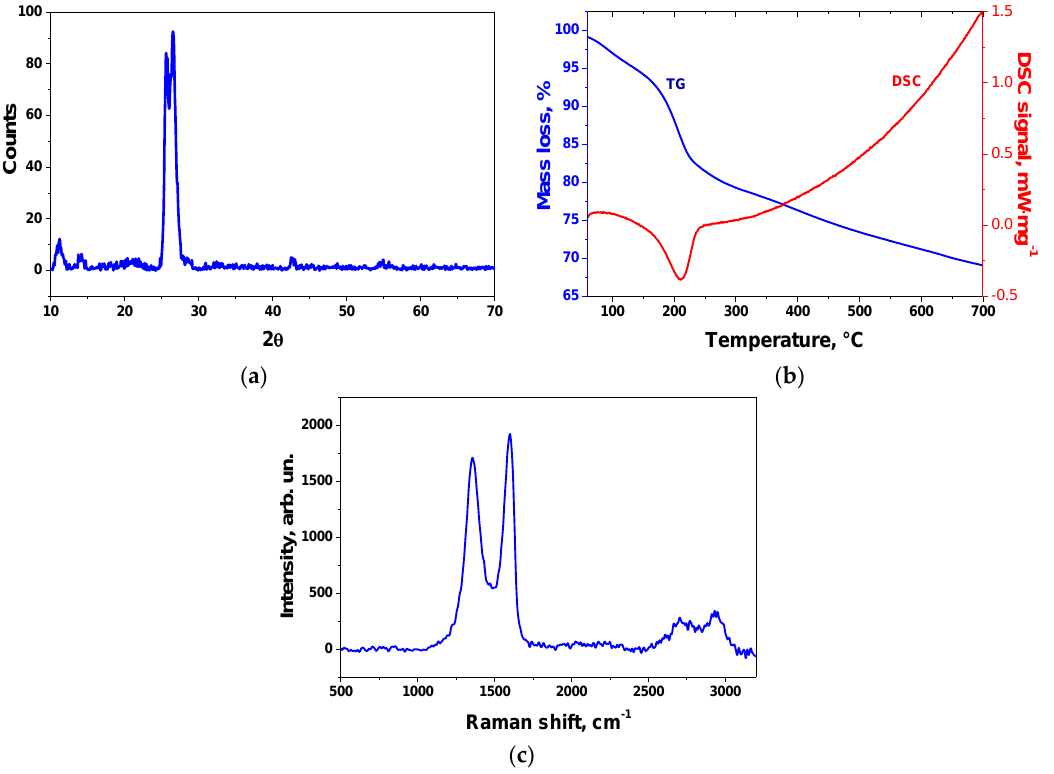
Figure 3. XRD pattern ( a ), TG/DSC curves ( b ), and Raman spectrum ( c ) of synthesized GO sample.